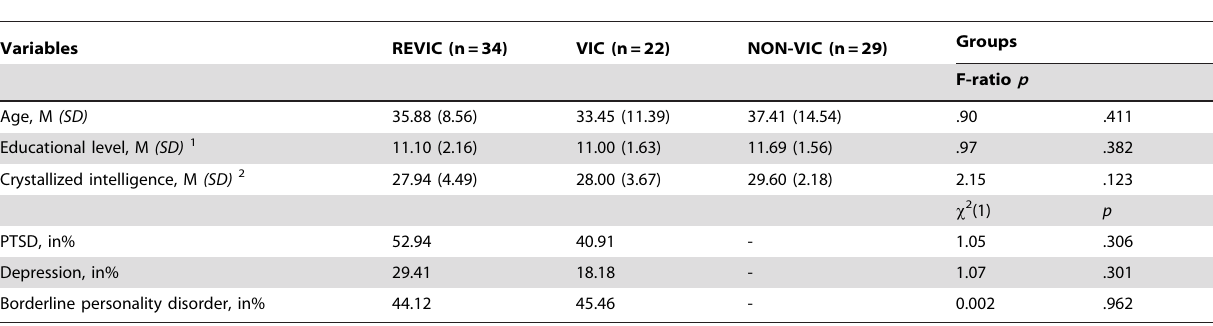
Table 2. Sociodemographic characteristics and psychopathology of the sample.